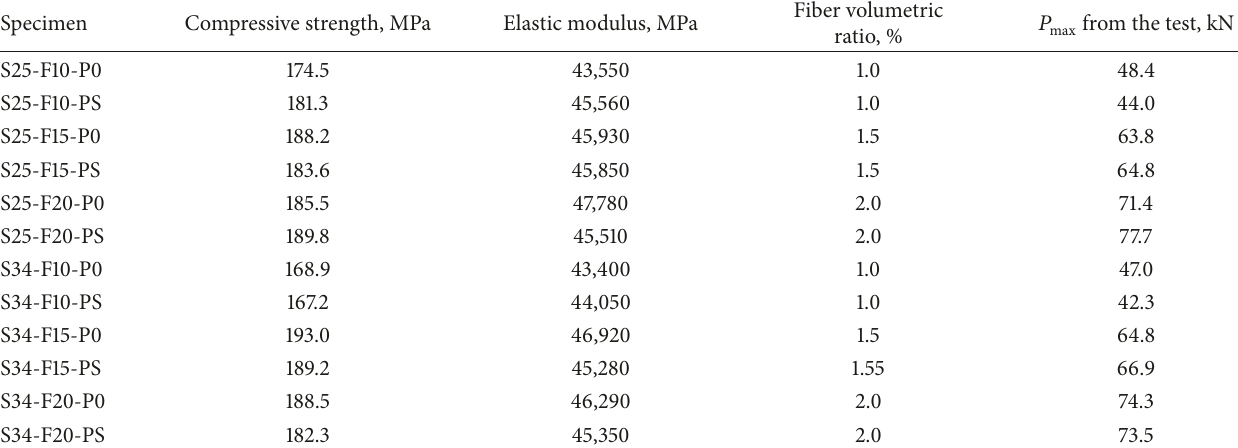
Table 2: Material properties of UHPFRC and the maximum load from the three-point bending test [18]. Specimen